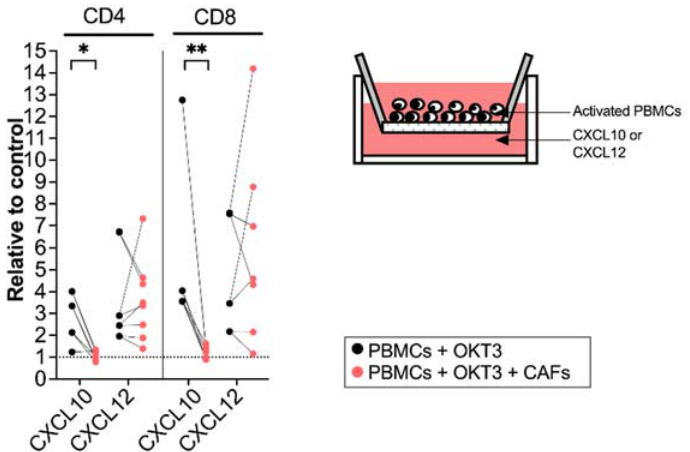
Figure 3. CAFs inhibit T cell migration towards CXCL10. PBMCs were precultured in the absence (black dots) or in the presence of CAFs (light red dots) and activated with OKT3 (25 ng/mL) for 5 days. ( Left ) Number of migrated CD4 + and CD8 + T cells towards CXCL10 (20 ng/mL) and CXCL12 (20 ng/mL). ( Right ) Schematic representation of the transwell migration assay. Wilcoxon signed ‐ rank test was used to detect statistically significant differences between paired samples. * p < 0.05, ** p < 0.01.